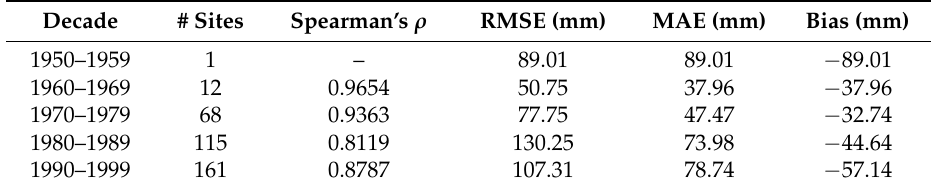
Table 2. Comparison of cumulative April 1 snow water equivalent (SWE) at SNOTEL and snowcourse